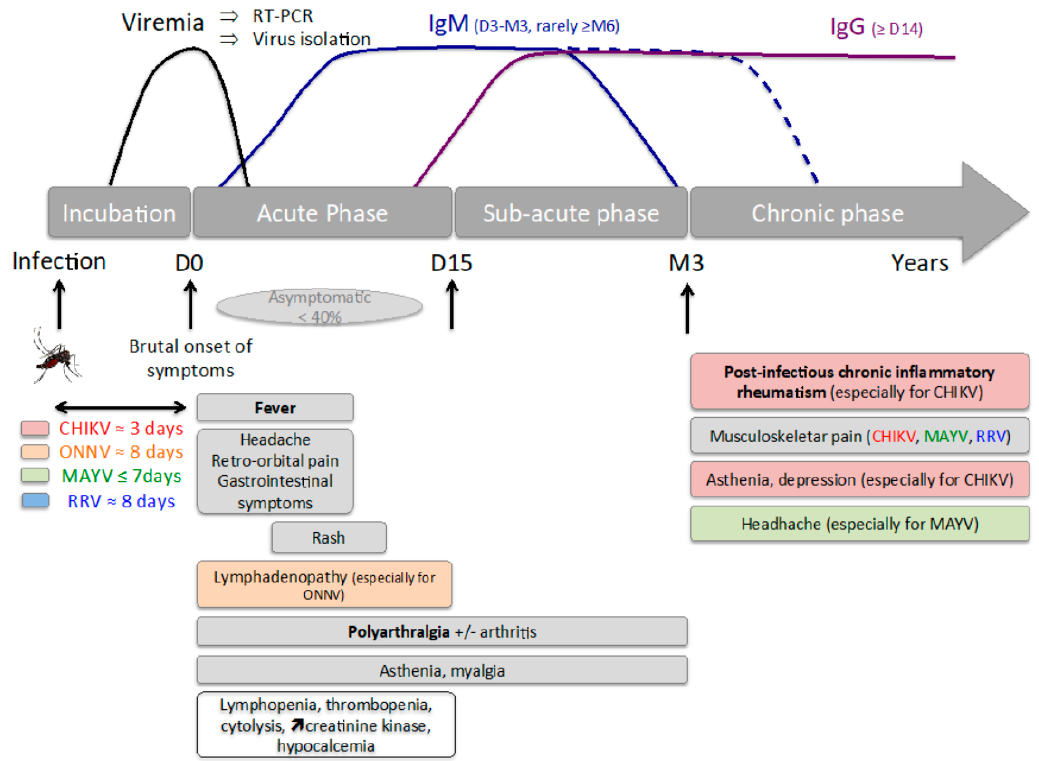
Figure 1. Timeline after arthritogenic alphavirus infection. After infection by a bite from an infected mosquito, an incubation period of 3–8 days takes place. Viremia starts before the onset of symptoms and lasts only a few days, leaving a very short window for direct diagnosis by RT-PCR or virus isolation. If the infection is symptomatic ( > 60% of cases), the patient presents with brutal onset of fever associated with polyarthralgia and other general symptoms, and after a few days, a delayed rash often appears. Lymphadenopathy is particularly frequent in ONNV infection. General blood tests during the acute phase can show lymphopenia, thrombopenia, hypocalcemia and mild rhabdomyolysis (with cytolysis and increased creatinine kinase). Polyarthralgia with or without arthritis and asthenia might be prolonged during the sub-acute phase (2 weeks to 3 months) or as chronic symptoms, sometimes as post-infectious chronic inflammatory rheumatism mimicking rheumatoid arthritis. Indirect diagnosis by serology requires two blood samples separated by at least 12 days to show appearance and / or disappearance of IgM (that may stay positive for over 6 months) and appearance of